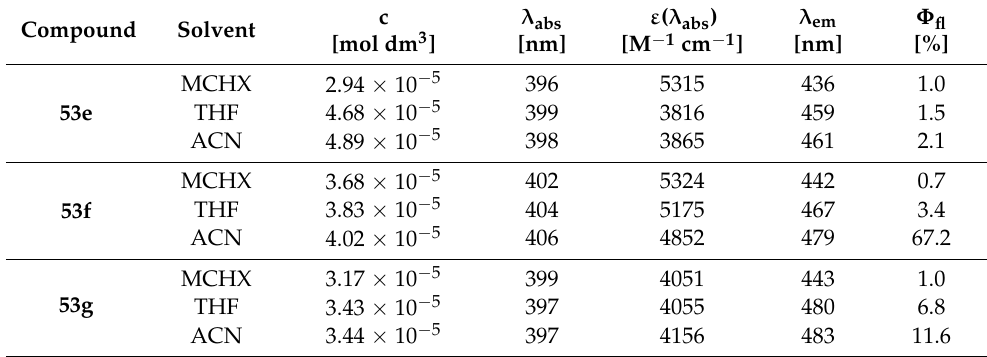
Table 9. The photophysical constants of the compounds 23e – g in different solvents. Compound